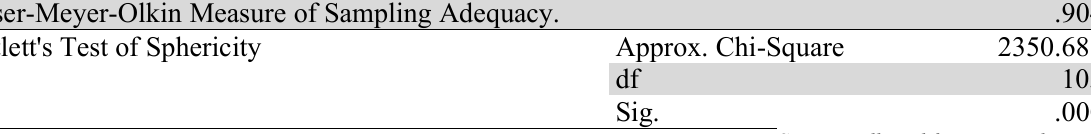
Results of KMO and Bartlett’s Test Kaiser-Meyer-Olkin Measure of Sampling Adequacy.